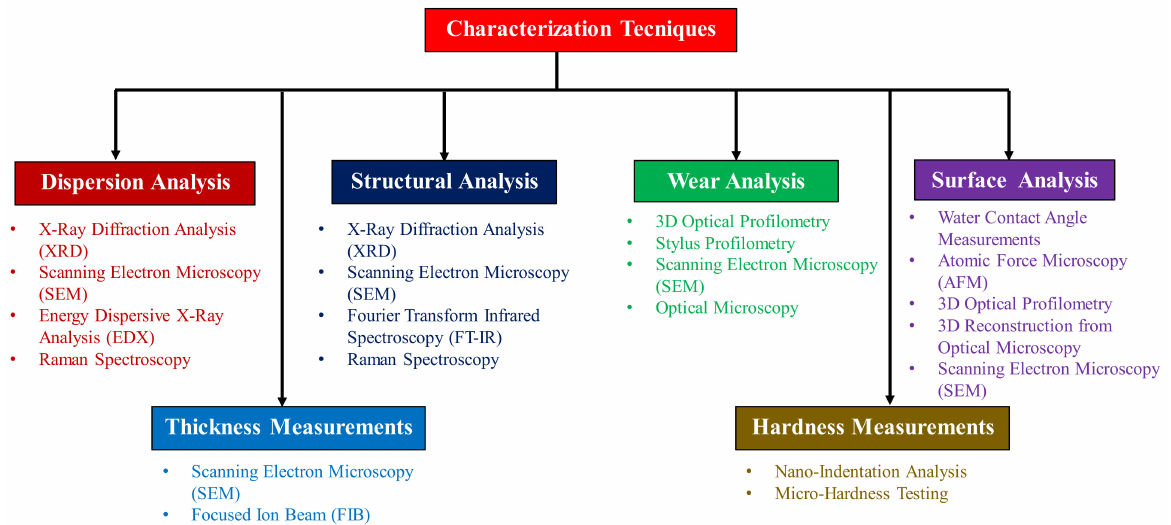
Figure 18. Various techniques used for characterizing the UHMWPE Nanocomposite coatings by different